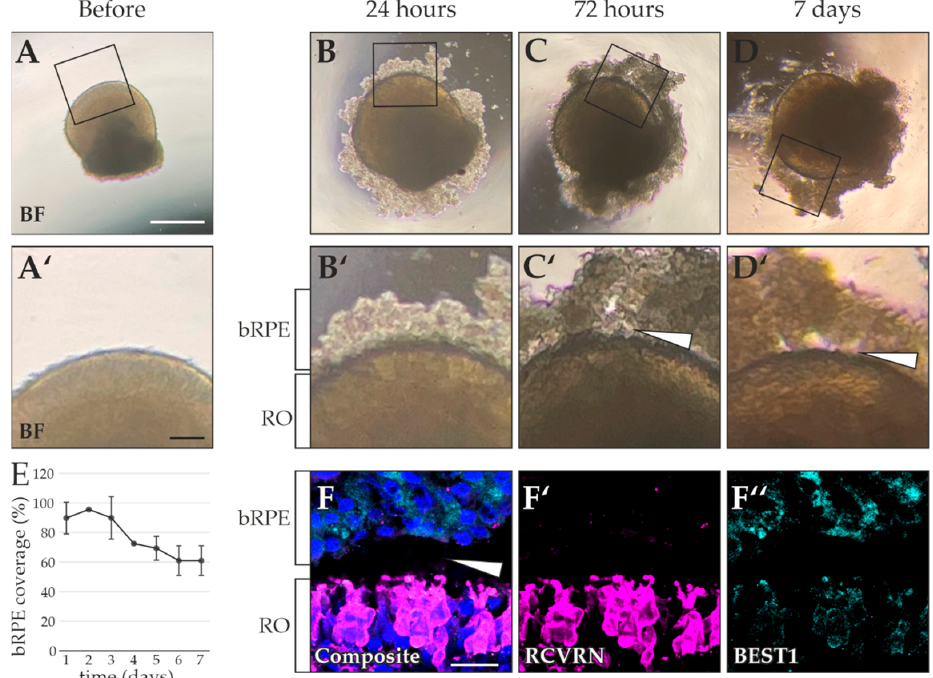
Figure 4 . Superficial interaction between byproduct RPE (bRPE) and retinal organoid (RO) photoreceptors. Brightfield (BF) images of the same RO ( A ) before, ( B ) 24 h, ( C ) 72 h, and ( D ) 7 days after coculture with dissociated bRPE. ( A , A’ ) Prior to coculture induction, no bRPE were located on the RO surface. ( B ) After 24 h, bRPE were observed around the entire RO perimeter. ( B’ ) Due to tight adherence of bRPE and RO photoreceptors, close physical proximity was suspected between the bRPE and the RO surface. ( C ) After 72 h, bRPE coverage around the RO had noticeably reduced. ( C’ ) Gaps formed between the bRPE and RO surface (arrowhead). ( D ) After 7 days, only minimal bRPE coverage remained. ( D’ ) Prominent cavities between bRPE and the RO were observed (arrow- head). ( E ) bRPE coverage of co-cultured ROs decreased over time. ( F,F’,F” ) ICC analysis confirmed the detachment of BEST1-positive bRPE (F”) from the RCVRN-positive photoreceptors (F’) within the RO (F, arrowhead). Counterstaining was performed with Dapi dye. Black squares in A–D indicate the location of the enlarged images shown in A’–D’. RO age: 105–150 days, bRPE age: 105 days. Scale bars: ( A – D ) 500 µ m, ( A’ – D’ ) 100 µ m, ( F – F” ) 10 µ